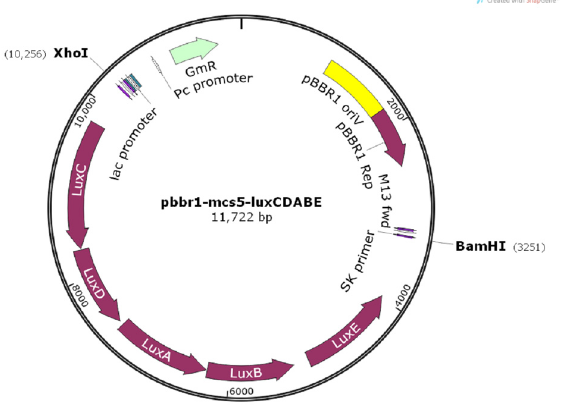
Figure 1. Construction of the pBBR1MCS-5- lux CDABE plasmid harboring the lux CDABE gene using Bam HI and Xho I.